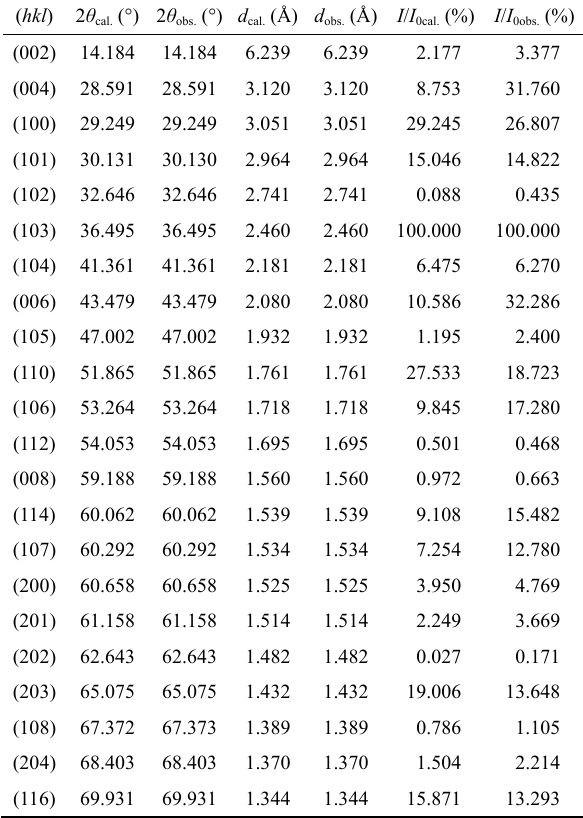
Table 5 Calculated and observed data of reflections: 2 θ , d -spacings, and intensities ( I ) of Hf 2